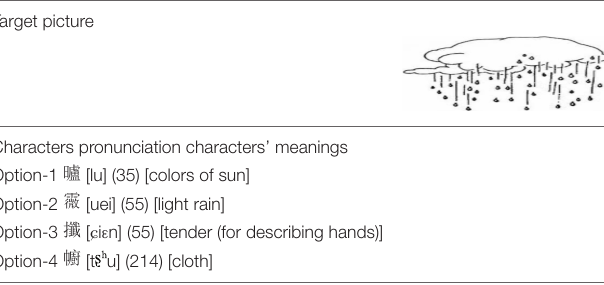
TABLE 1 | An example of the radical analysis